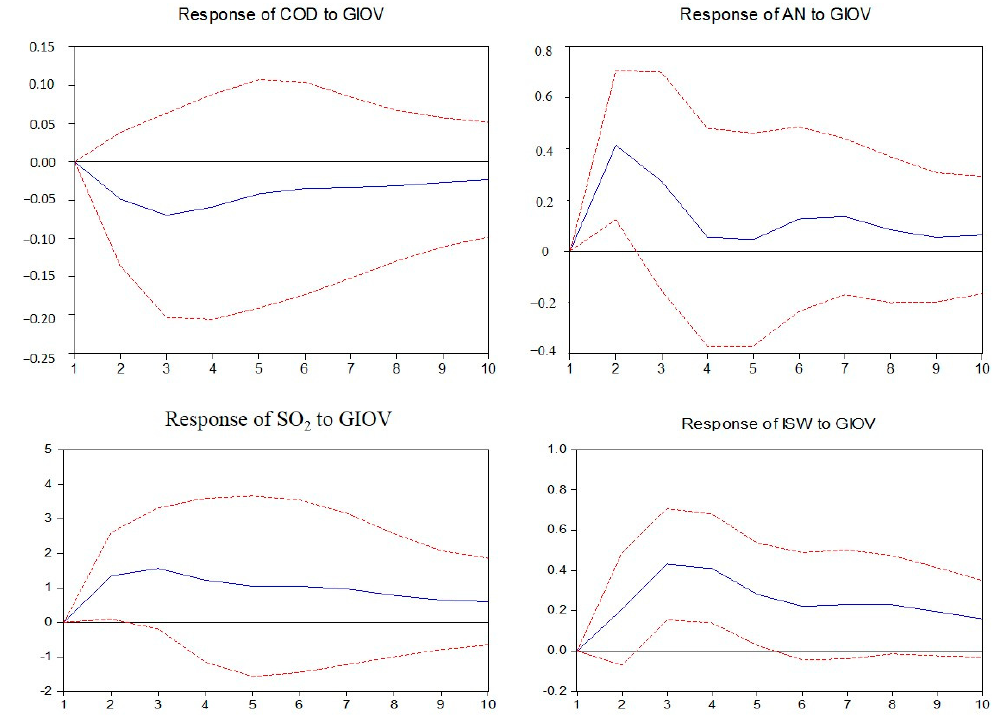
Figure 11. Responses of pollutants charged to industrial output value of mining and processing of ferrous metal ores. The solid lines indicate the mean responses to a one standard deviation shock, while the dotted lines represent ± 2 standard deviations of the responses.